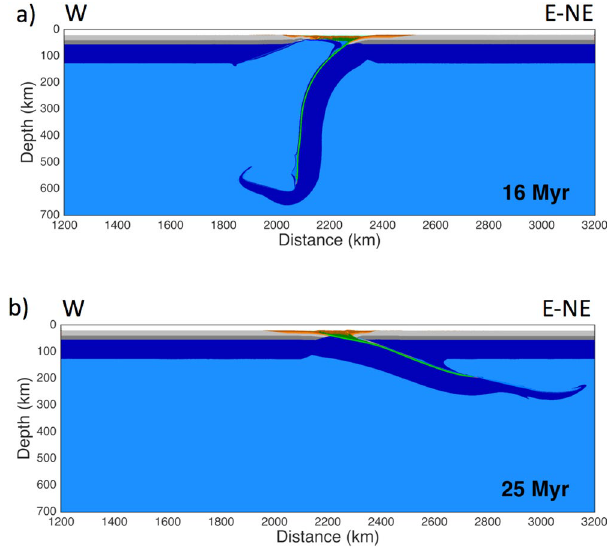
Figure 2. Panel ( a ) shows a W-directed slab. All numerical models present pre-defined rightward subduction polarity; therefore this model was mirrored for better comparison with nature. In panel ( b ) a slab along E or NE-subduction zone is designed. In each model a horizontal mantle flow is imposed, having concordant or opposite direction with respect to the subduction polarity. The difference in dip of the slab is striking: the “westerly” dipping slab is steeper and deeper, whereas “easterly or northeasterly” dipping slab is shallower and less steep. The difference is also remarkable comparing back-arc spreading or not: in fact this latter only occurs in “westwardly” directed slab model ( a